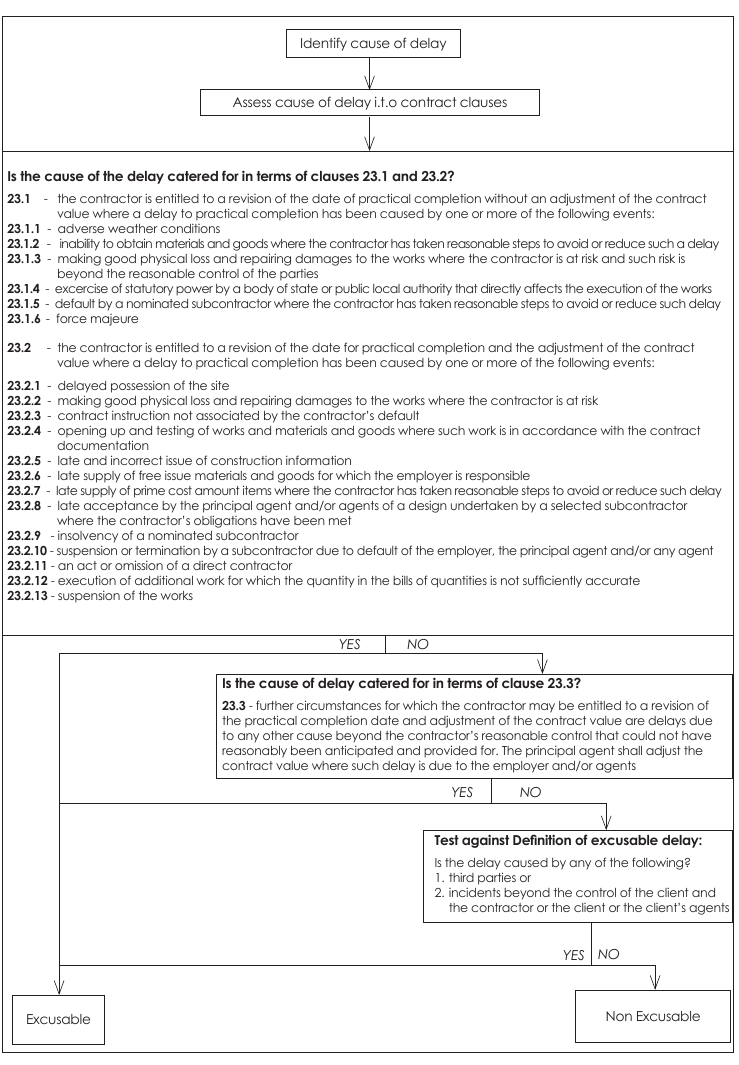
Figure 5: Decision tree: JBCC excusable delay or